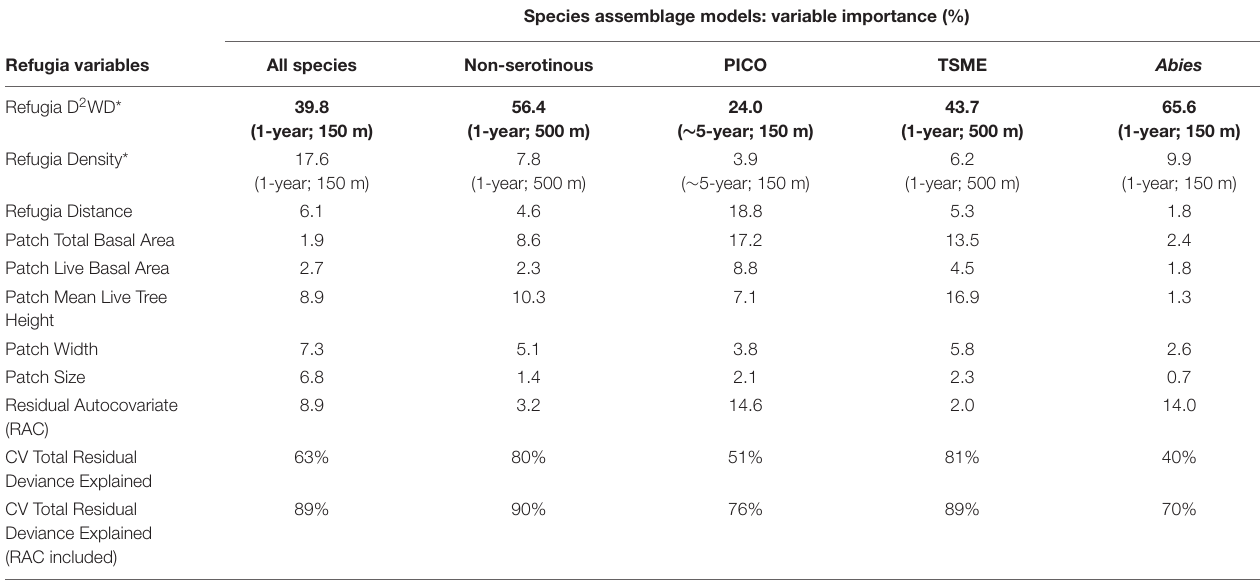
TABLE 2 | Variable Importance and model performance from the BRT models evaluating relationships between observed conifer juvenile establishment and patch- or neighborhood-based estimates of fire refugia, by species assemblage. Species assemblage models: variable importance